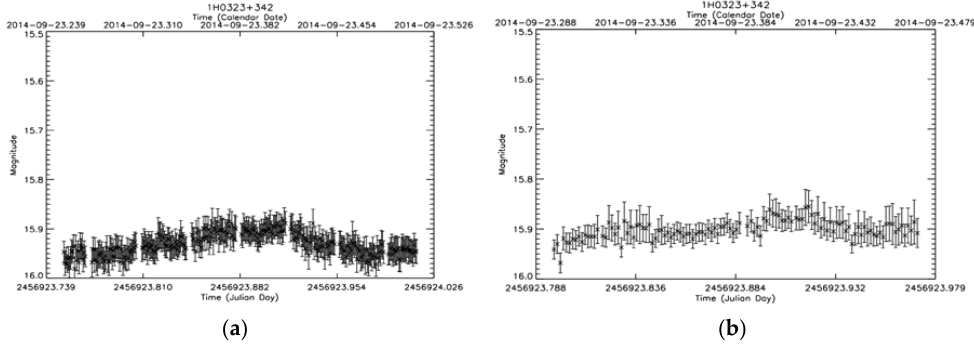
Figure 6. Intra-night light curves (LC) of 1H 0323+342. The LC taken using the 72-in is shown as (a), and the LC taken with the 31-in is shown as (b). Both light curves are plotted on a 0.5 magnitude scale. Microvariablity remains detectable for this object, albeit on a much smaller scale than for J0849+5108 or J0948+0022. Data was obtained in the optical R band.